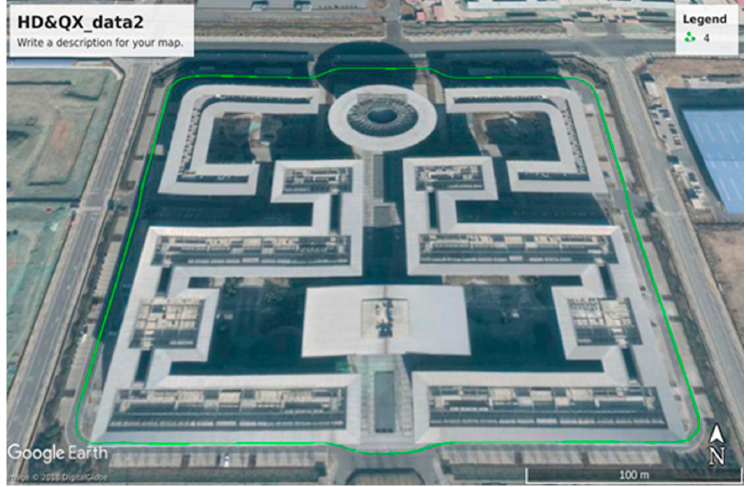
Figure 11. Dynamic test effect chart.